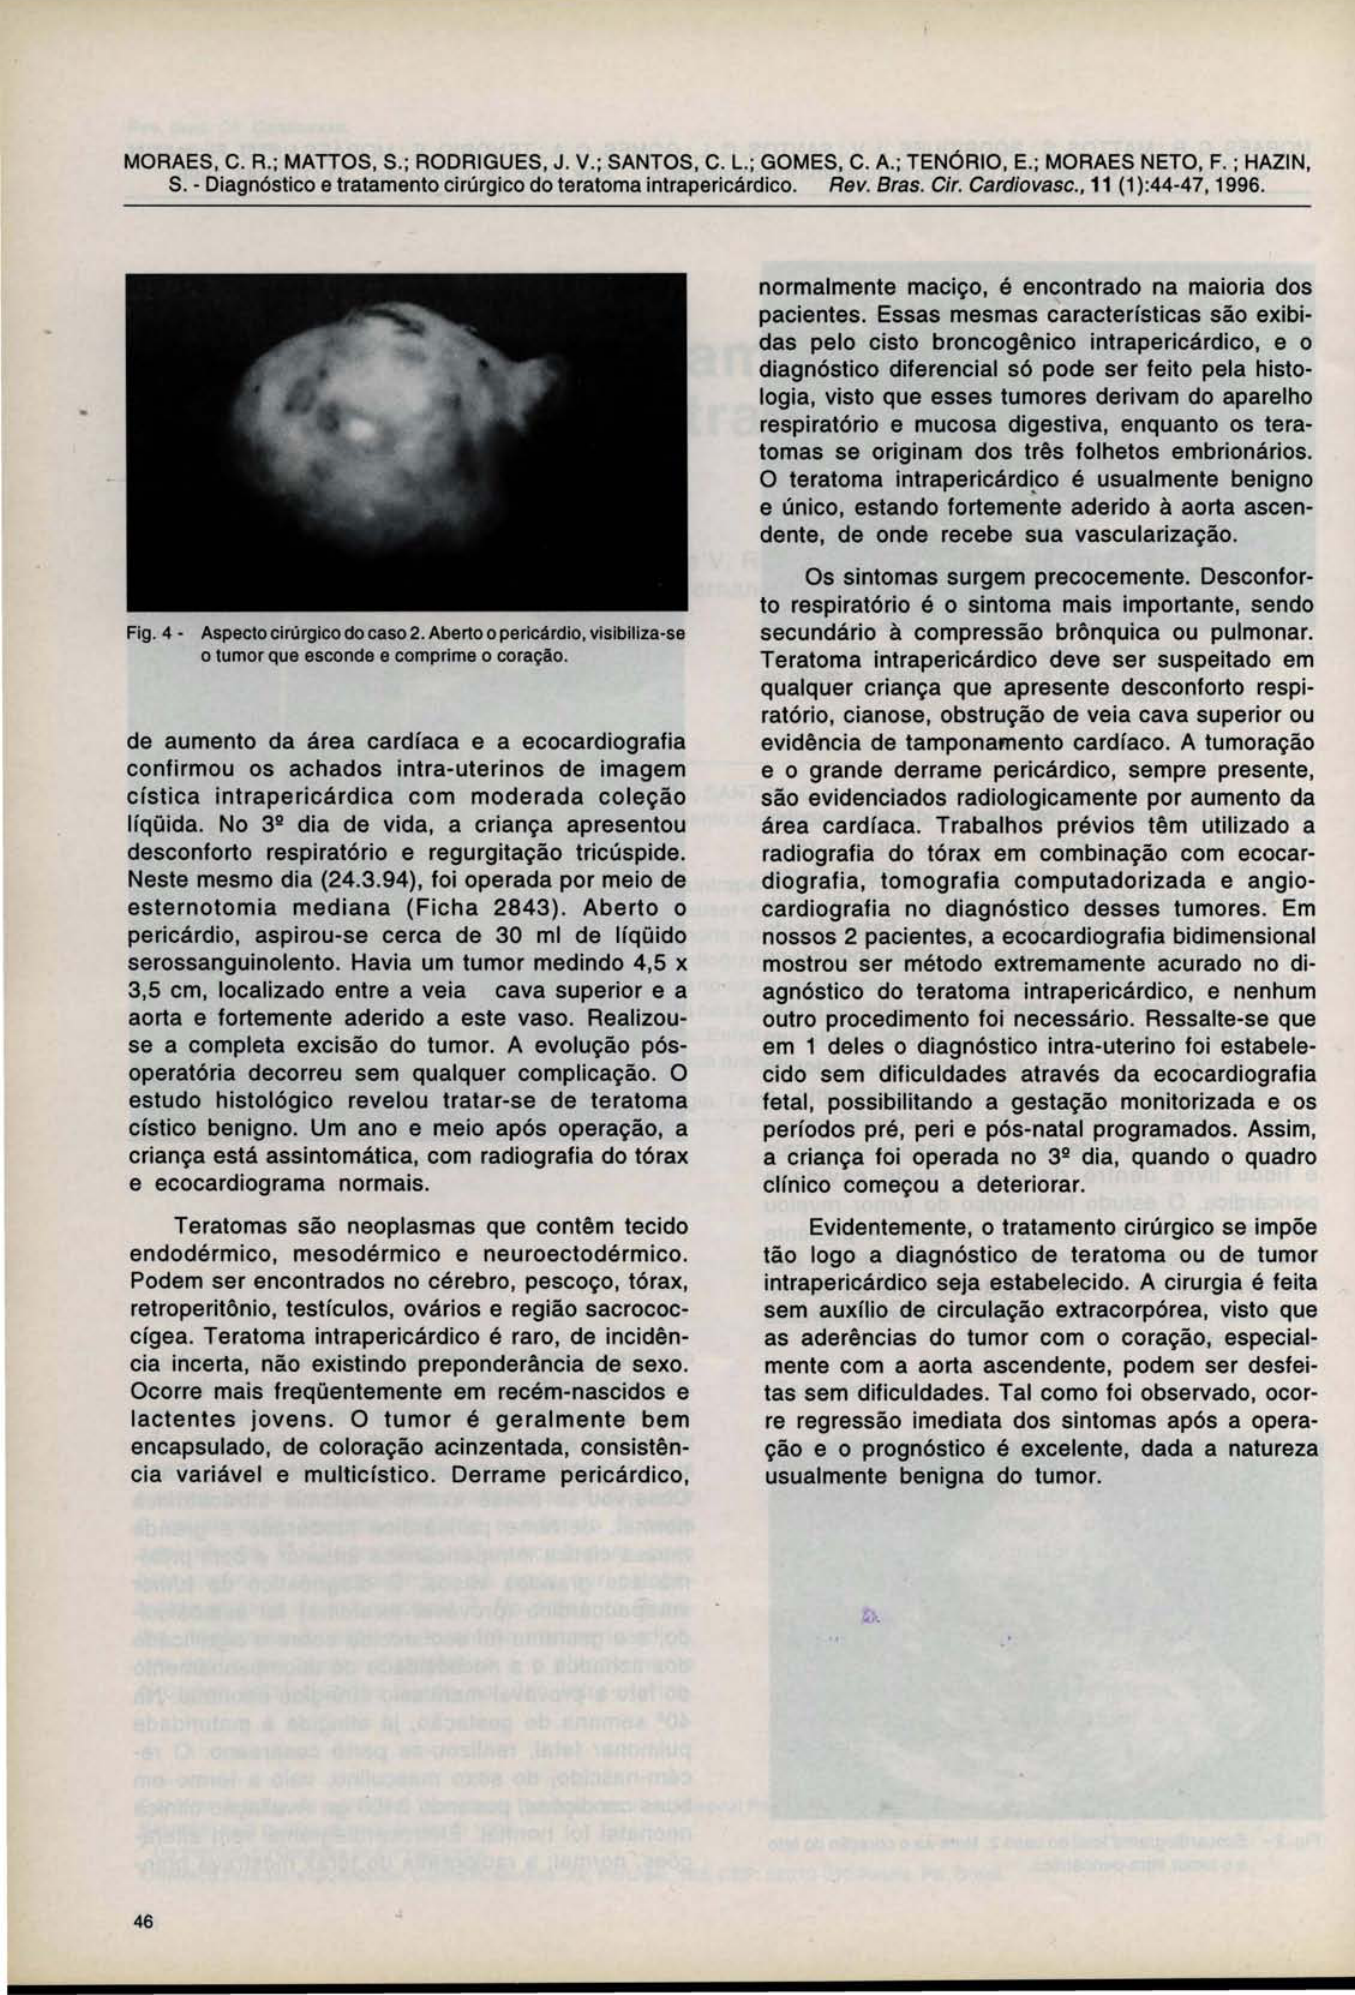
Fig. 4 - Aspecto cirúrgico do caso 2. Aberto o pericárdio, visibiliza-se o tumor que esconde e comprime o